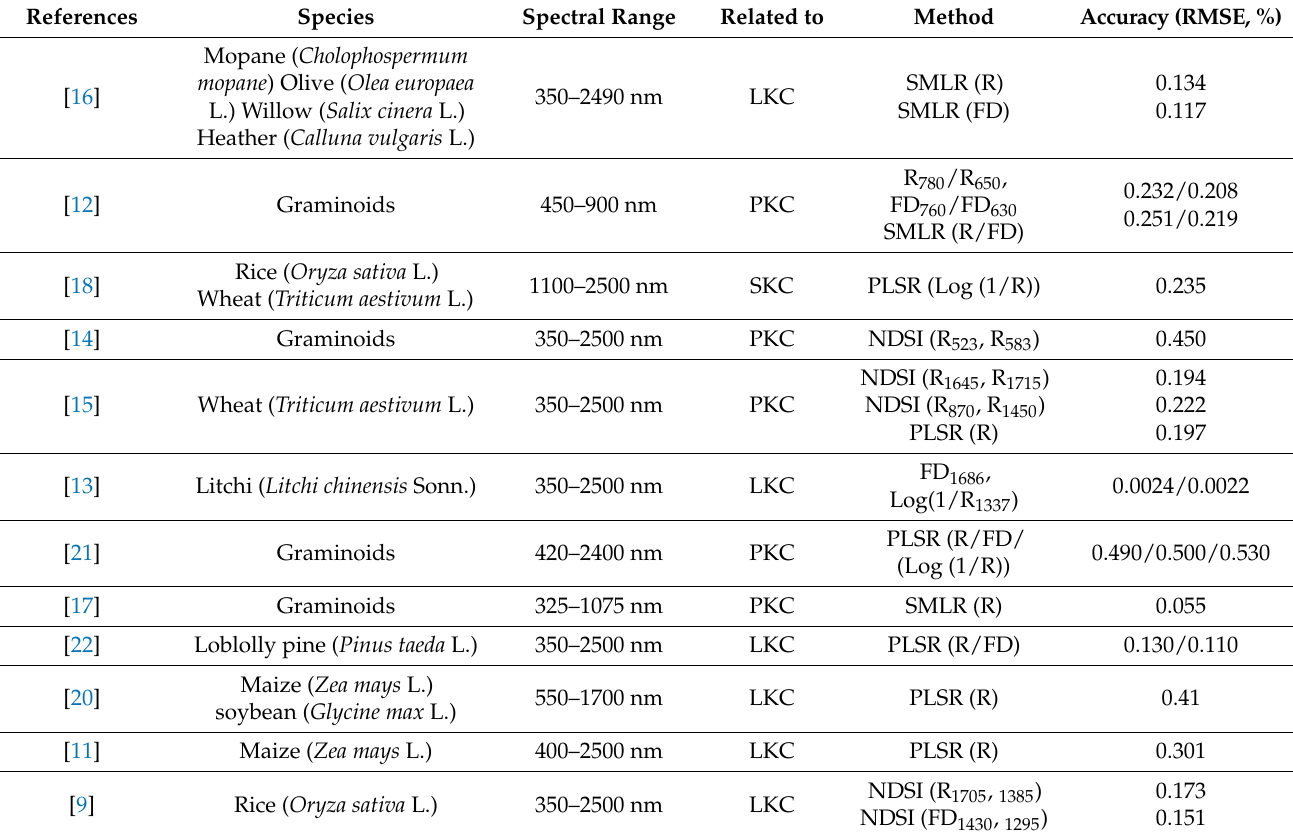
Note: SKC = straw potassium content, LKC = leaf potassium content, PKC = plant potassium content, R = reflectance, FD = first derivative spectra, Log (1/R) = reciprocal logarithm-transformed spectra, SMLR = stepwise multiple linear regression, PLSR = partial least-squares regression, and NDSI = normalized difference spectral